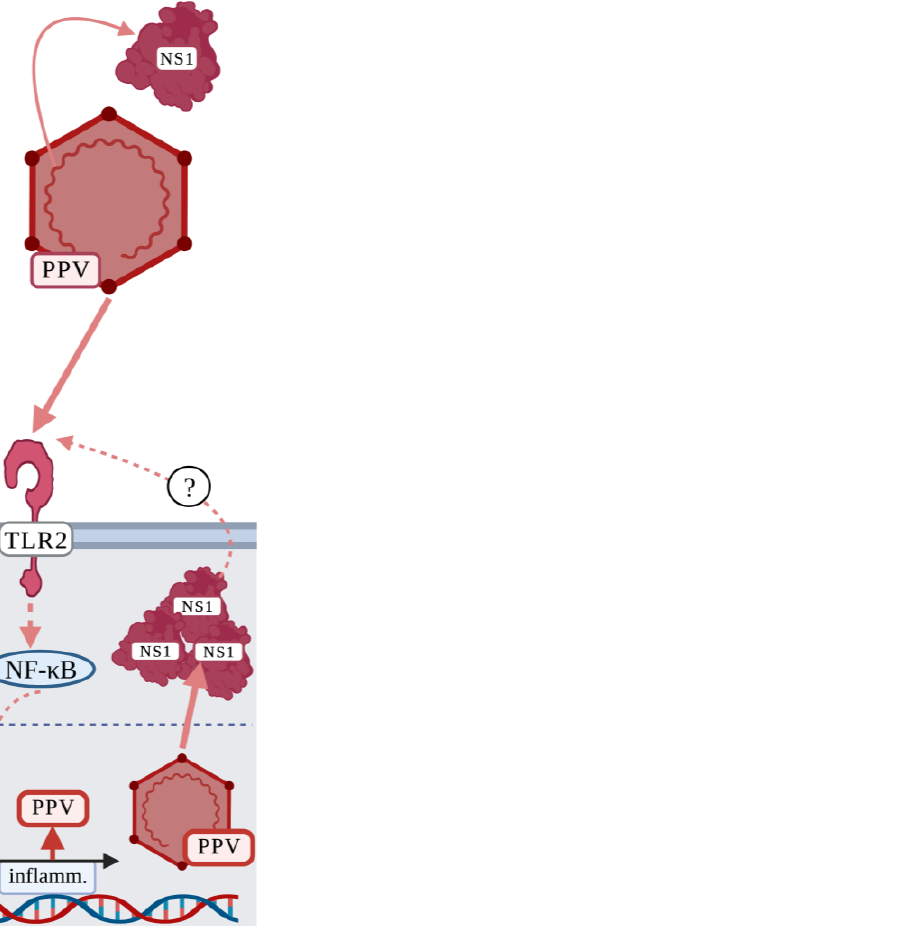
Figure 3. Baltimore Classification II viruses recognized by surface TLRs: for Baltimore Class II, Porcine Parvovirus (PPV) activated an inflammatory response via TLR2-NF- κB signaling, likely involving NS1.